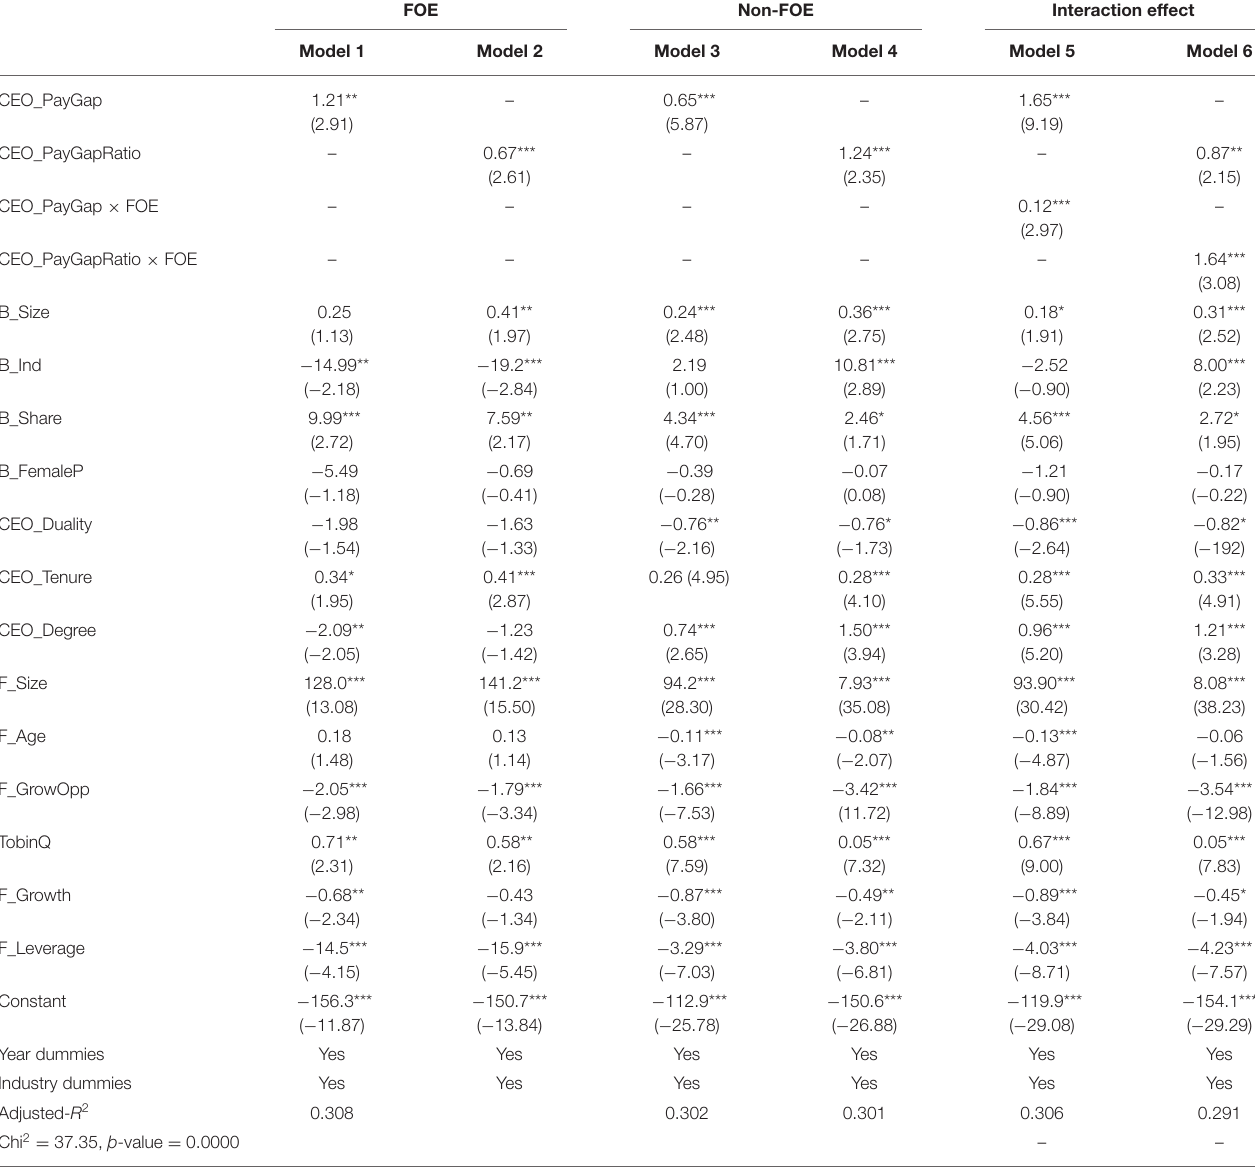
TABLE 3 | CEO tournament incentive and corporate social responsibility performance (sub-sample FOEs vs. non-FOEs) and interaction